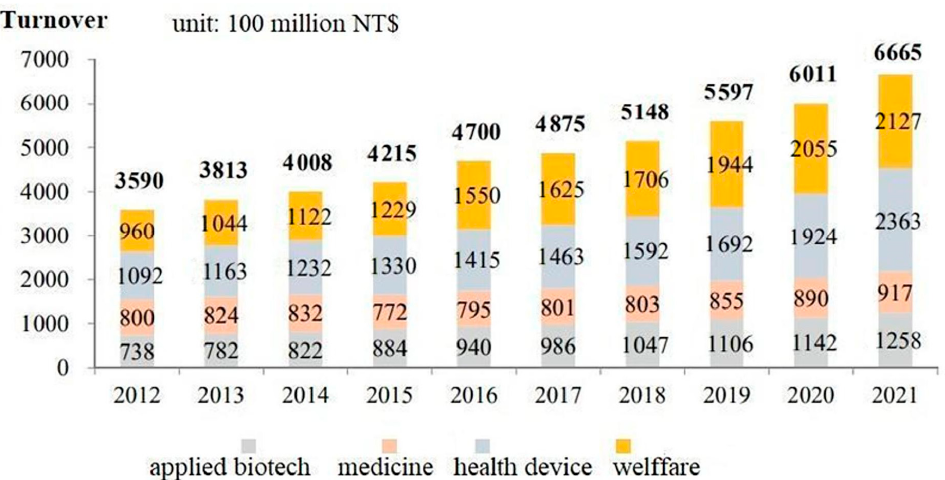
Chart 1. Growth trend of Taiwan’s biotechnology turnover Source: Ministry of Economic